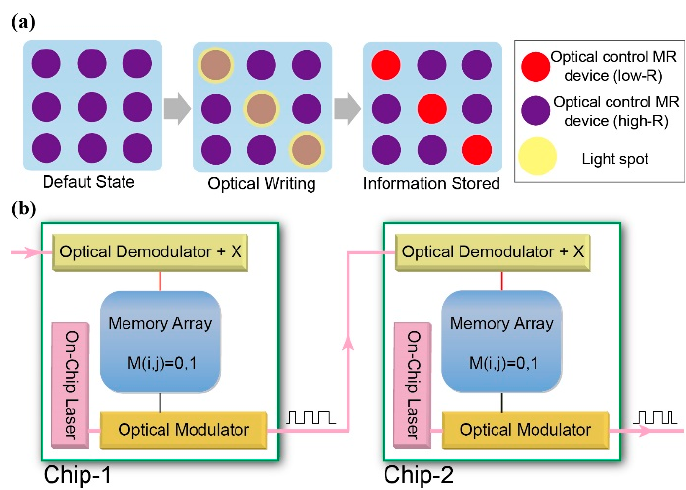
Figure 5. Schematic of the potential applications of the OTMR effect ( a ) Data writing in optical control MR chip. This chip, based on the OTMR devices array, can serve as a memory module in the following chips in ( b ); ( b ) Inter-chip optical communication. According to the data stored in the “Memory Array” on Chip-1, the laser beam from the “On-Chip Laser” can be modulated by the “Optical Modulator” to convey the information. Once another chip (“Chip-2”) receives the modulated laser beam from Chip-1, the “Optical Demodulator + X” unit will demodulate the beam and then write the “Memory Array” on Chip-2 in an optical writing way utilizing the laser-induced change of MR (the “X” may be a laser demultiplexer to perform selected data writing into specific memory unit).